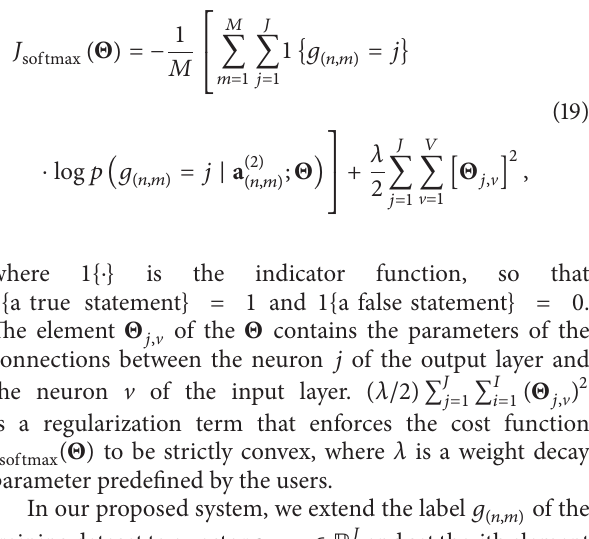
Here Θ ∈ R 𝐽×𝑉 is the network parameter of the softmax (2) 𝐽 is the number of ( 𝑉 is the dimension of the input a (𝑛,𝑚) , and the classes within the input data). Θ 𝑇 𝑗 represents the transpose of the 𝑗 th row of Θ and contains the parameters of the connections between the neuron 𝑗 of the output layer and the (2) input sample a (𝑛,𝑚)